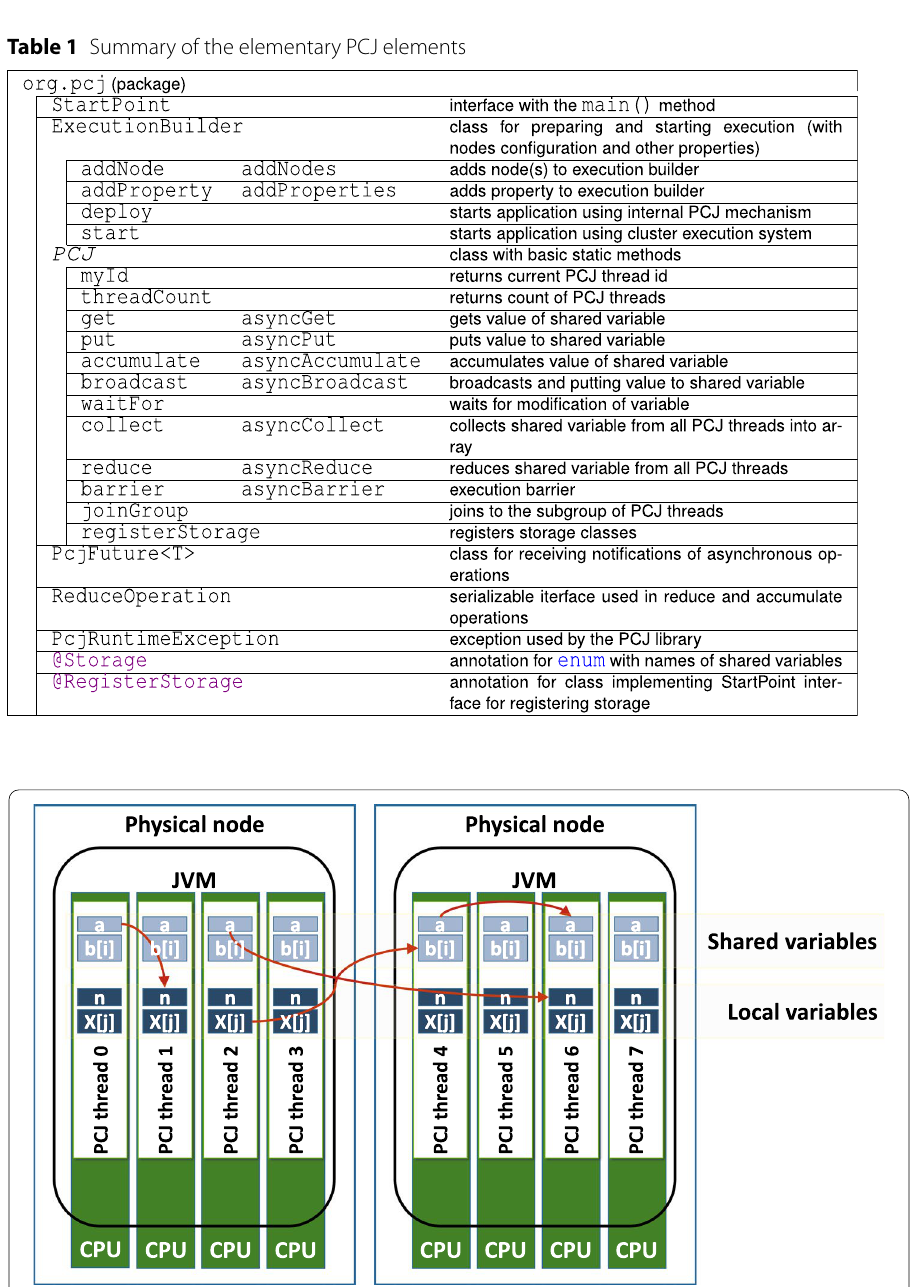
Fig. 2 Diagram of PCJ computing model (from [48]). Arrows present possible communication using put(...) or get(...) methods acting on shared